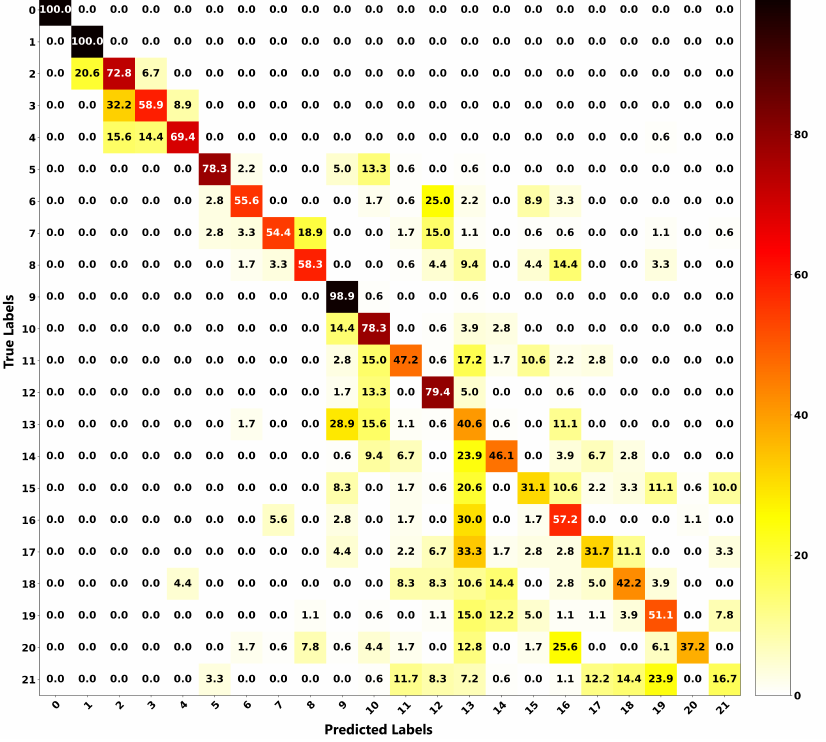
Figure 17. Confusion matrix for localization based on modified Castigliano’s theorem, evaluated on test